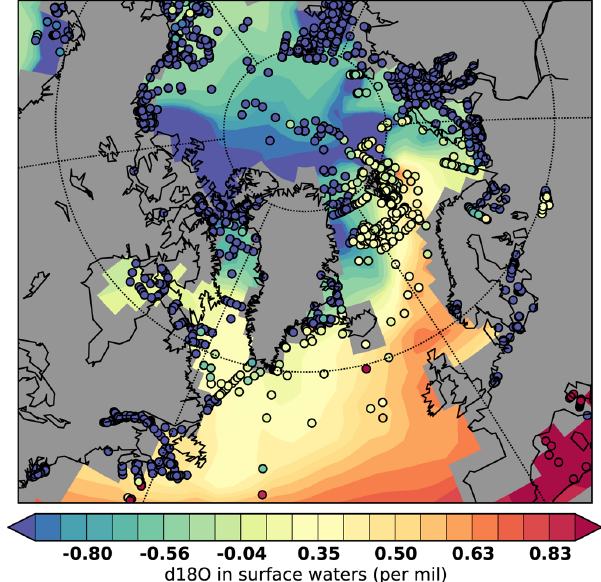
Fig. 9. Same as Fig. 8 but zoomed on the North Atlantic